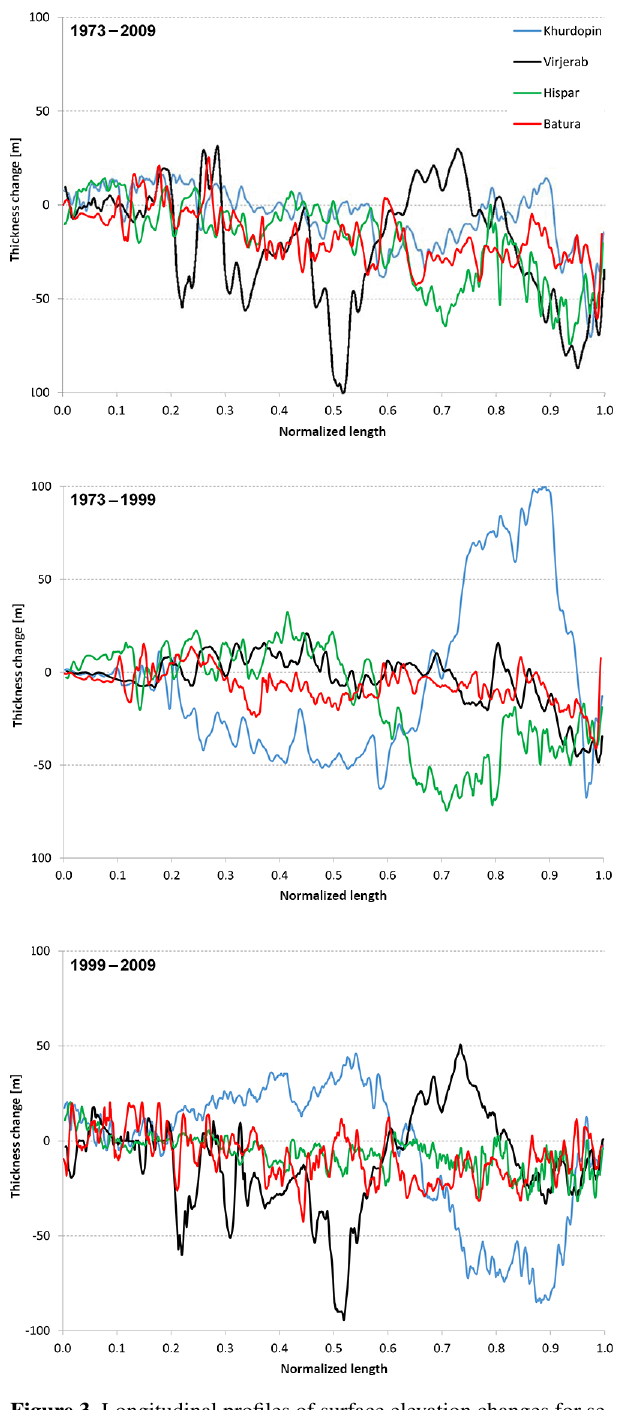
Figure 3. Longitudinal profiles of surface elevation changes for se- lected glaciers for the entire period (1973–2009) and the subperiods 1973–1999 nd